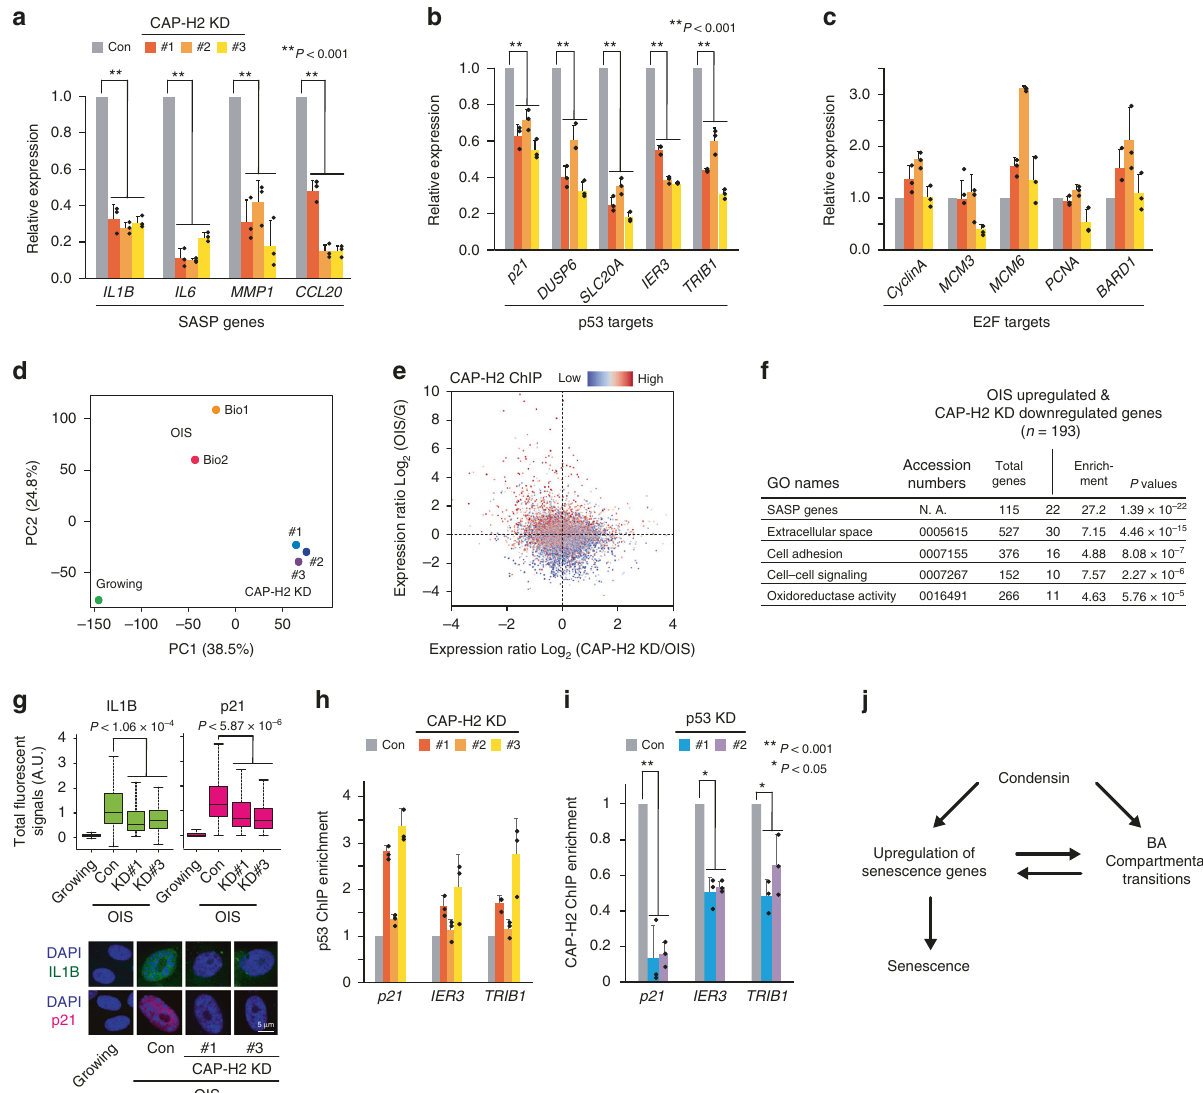
Fig. 8 Effects of CAP-H2 condensin depletion on gene regulation in OIS cells. a – c Effect of CAP-H2 KD on mRNA levels of the SASP ( a ), p53 target ( b ), and E2F target genes ( c ). RNA levels of the indicated genes in OIS (control) and CAP-H2 KD (#1-#3) cells were quanti fi ed by RT-qPCR. P -values were calculated by two-sided Student ’ s t -test, using biologically independent samples ( n = 3, error bars represent the SD). d PCA of RNA-seq data showing similarities and differences in global expression pro fi les among growing, OIS (Bio1 and Bio2) and CAP-H2 KD (#1-#3) IMR90 cells. The positioning of growing and CAP-H2 KD cells at a similar location along the PC2 axis indicates that gene expression pro fi les in these cell populations are correlated. PC1, PC2, principal components 1 and 2. e Correlation between genes that were upregulated upon OIS and downregulated by CAP-H2 KD. Expression ratios between OIS and growing cells were compared to those between CAP-H2 KD and OIS cells. Upper left quadrant indicates 4553 genes that were upregulated by OIS and downregulated by CAP-H2 KD. Dot colors re fl ect CAP-H2 ChIP-seq enrichment scores. f GO analysis of genes ( n = 193) signi fi cantly upregulated upon OIS and downregulated by CAP-H2 KD, showing enrichment in SASP and other senescence genes (Fisher exact test). g Immuno fl uorescent (IF) visualization of IL1B (SASP factor) and p21 (p53 target; cell-cycle regulator) in OIS and CAP-H2 KD cells. Nuclear IF signals were quanti fi ed in more than 100 cells (Methods), and distributions of nuclear IF signals shown as boxplots (central bar represents the median with boxes indicating the upper and lower quartiles, and whiskers extend to the data points, which are no more than 1.5× the interquartile range from the box) were compared between CAP-H2 KD and control cells (two-sided Mann – Whitney U test). h Effect of CAP-H2 KD on p53 binding at p53 target genes in IMR90 OIS cells, as determined by ChIP-qPCR. i Effect of p53 KD on CAP-H2 binding at the indicated p53 target genes in OIS cells. Cells were prepared as in Fig. 7a except that CAP-H2 KD was replaced by p53 KD. P -values were calculated by two-sided Student ’ s t -test, using biologically independent samples ( n = 3, error bars represent the SD). j A model explaining how condensin may mediate gene regulation and compartmental reorganization during senescence processes. A hypothesis is that condensin participates in the upregulation of senescence genes and BA transitions, both of which are not completely independent to each